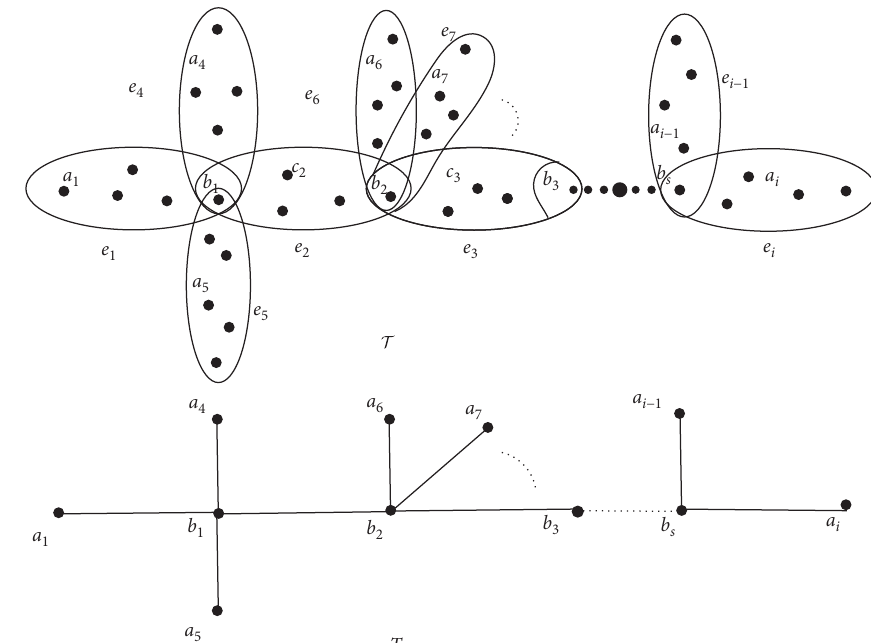
Figure 2: The k -uniform hypertree T and the induced tree T .